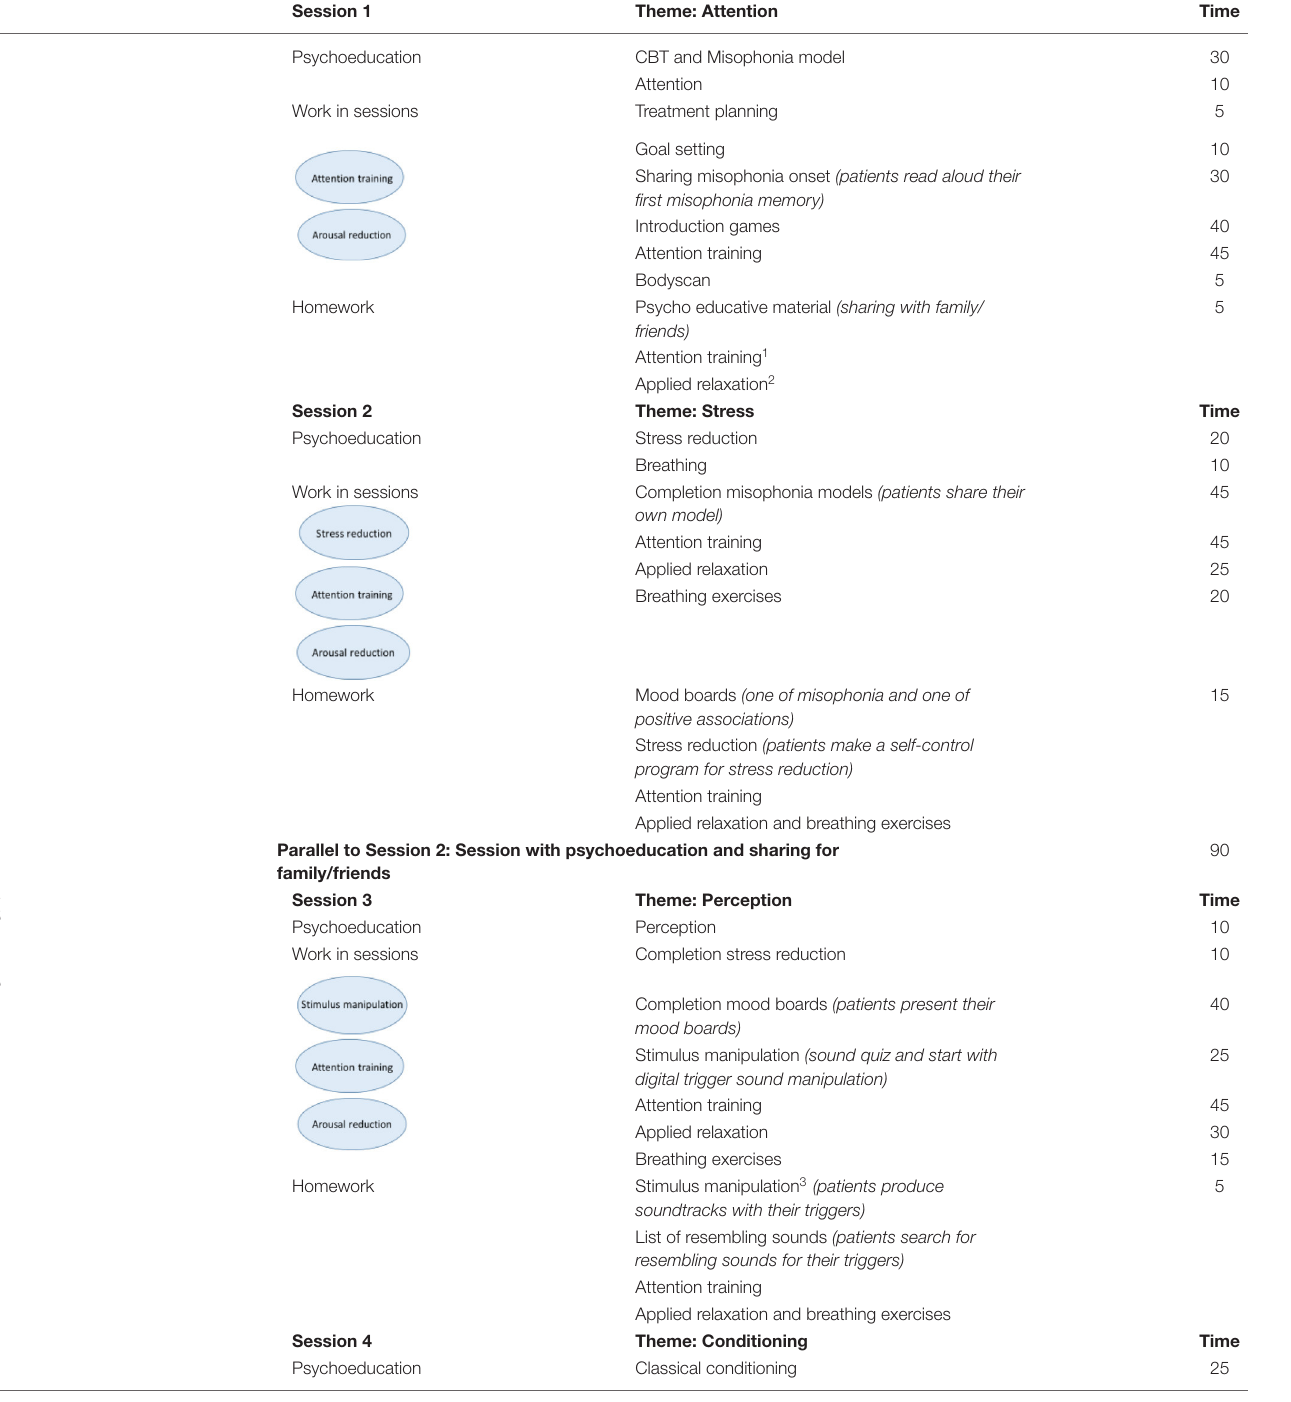
TABLE 2 | Overview treatment protocol per